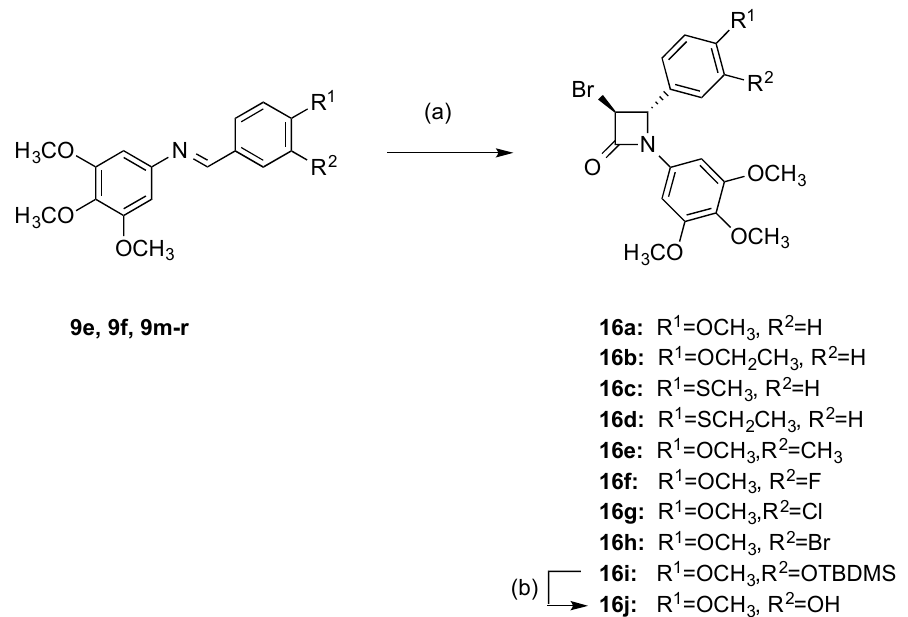
Scheme 3. Synthesis of β -lactams 16a-i. Reagents and conditions: ( a ) BrCH 2 COCl, toluene, reflux, 5 h (5–31%); ( b ) TBAF, dry THF, 0 °C, 30 min (32%).